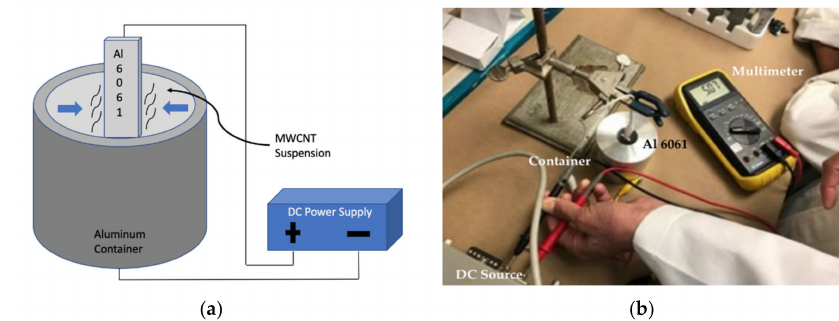
Figure 2. Electrodeposition process of MWCNTs over Al6061. ( a ) Schematic view of the electrophoresis deposition (EPD), which is carried out by applying a voltage between the cathode (container) and the anode (sample), inducing the motion of the MWCNTs in the suspension to produce a thin film over the sample. ( b ) Test setup of the array used to perform the EPD over Al6061 material samples. The voltage supplied source was carefully controlled to ensure repeatability over the carry out experiments.